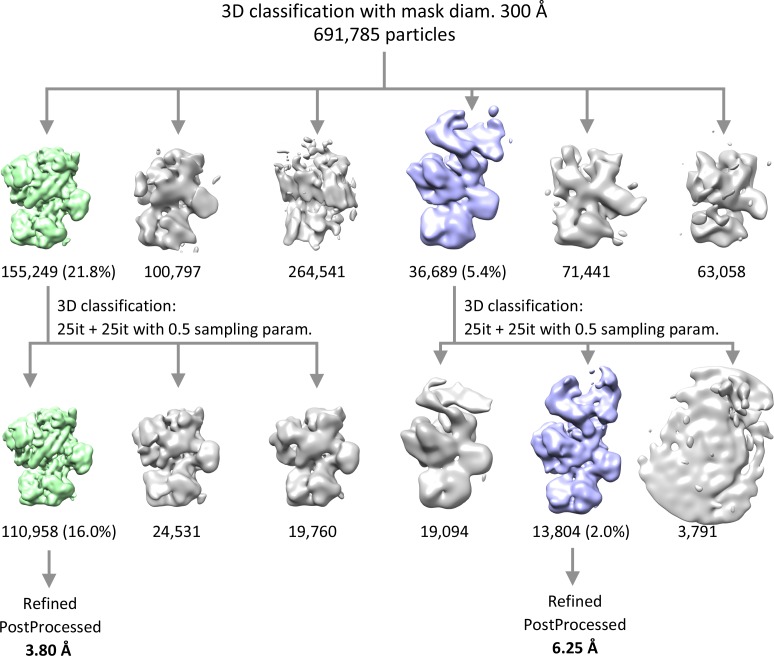
Cryo-EM data processing scheme.The 691,785 particles from the 2D classification were initially 3D classified into six classes, using 300 Å mask. Two best classes representing the hEXO-10 and the hEXO-14 complexes were subsequently aligned and 3D classified further separately into three classes each, using finer sampling parameters. The best 3D classes of the hEXO-10 and the hEXO-14 were autorefined and postprocessed.